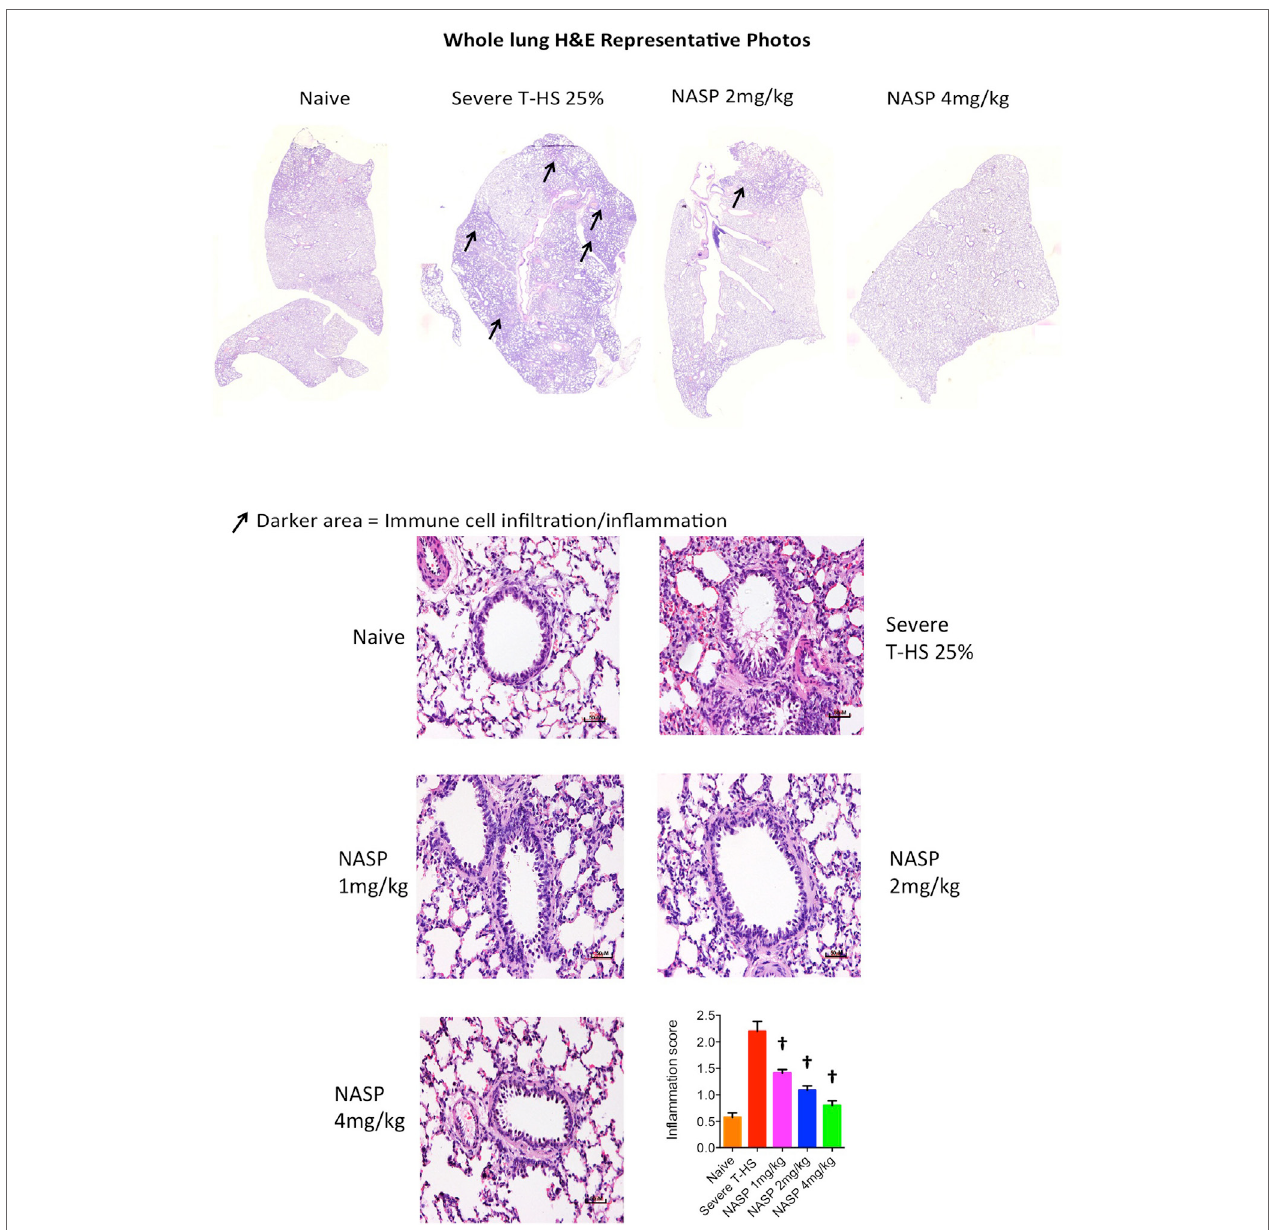
FigUre 7 | Nucleic acid scavenging polymer (NASP) (hexadimethrine bromide) treatment of rodent T-HS improved lung histological appearances. Hematoxylin & eosin (H&E) staining to measure cell infiltration into the airway, an indicator of airway inflammation. NASP treatment showed a dose-dependent attenuation of cellular infiltration. † denotes p < 0.01 vs untreated severe T-HS 25%, t -test. n = 4–7 animals per group. Mean values with SEM bars shown. Scale bars represent 50